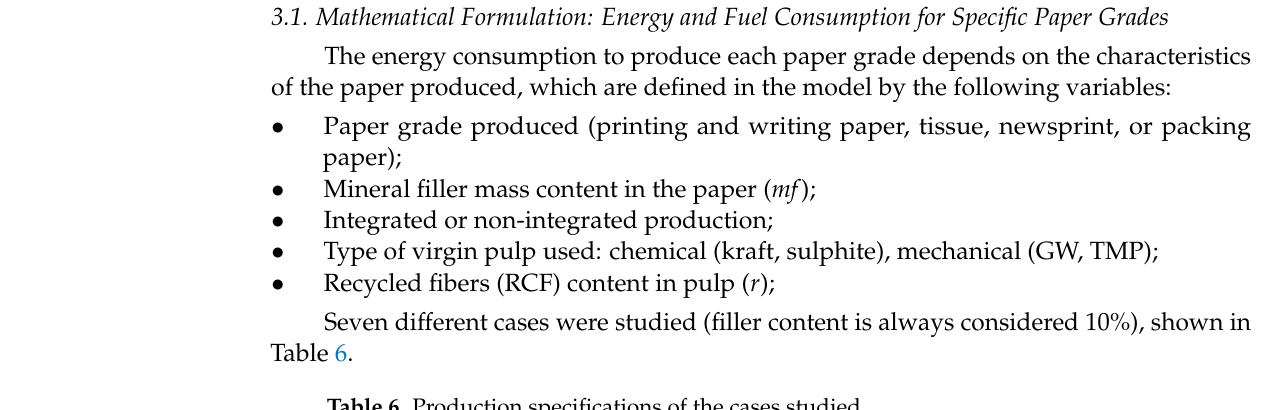
Table 6. Production specifications of the cases